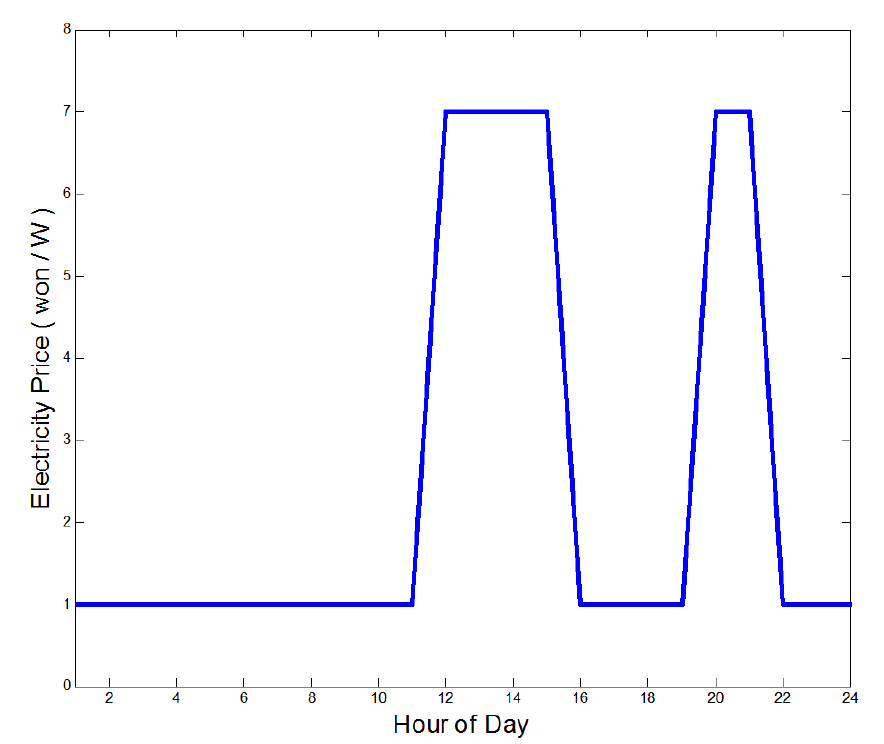
Figure 7. An example of a critical peak pricing (CPP)